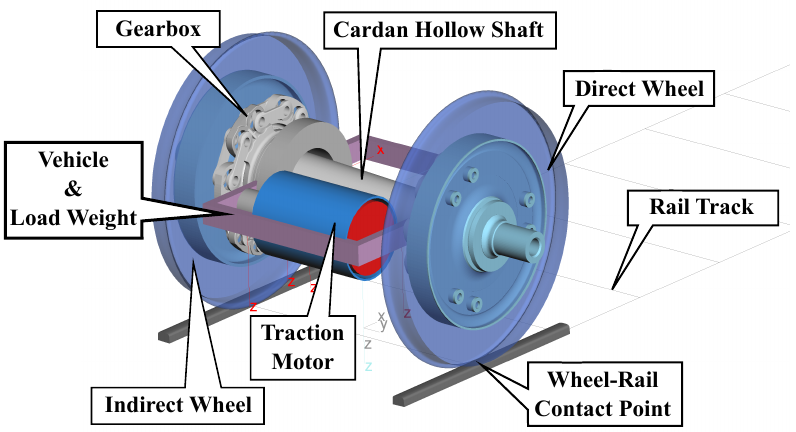
Figure 5. MBS model of the drivetrain with wheel–rail